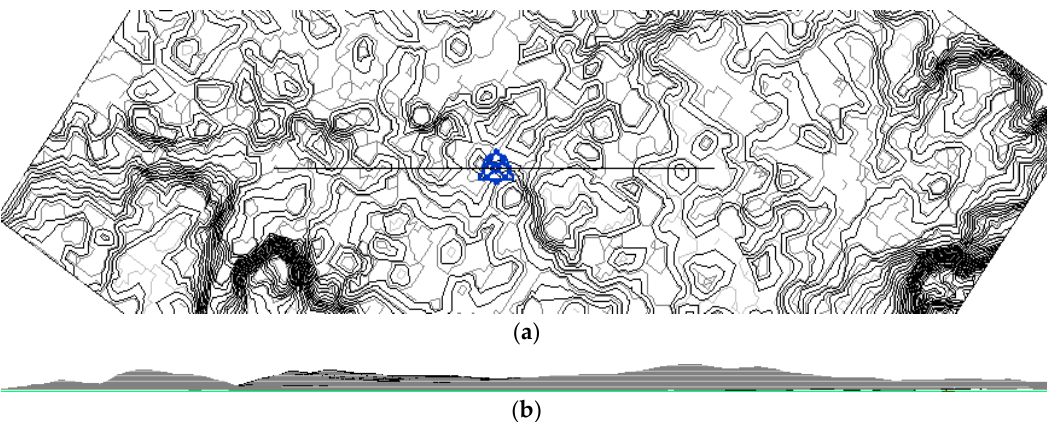
Figure 7. 3D model of the terrain created in Revit®: (a) plan view; and (b) longitudinal profile.